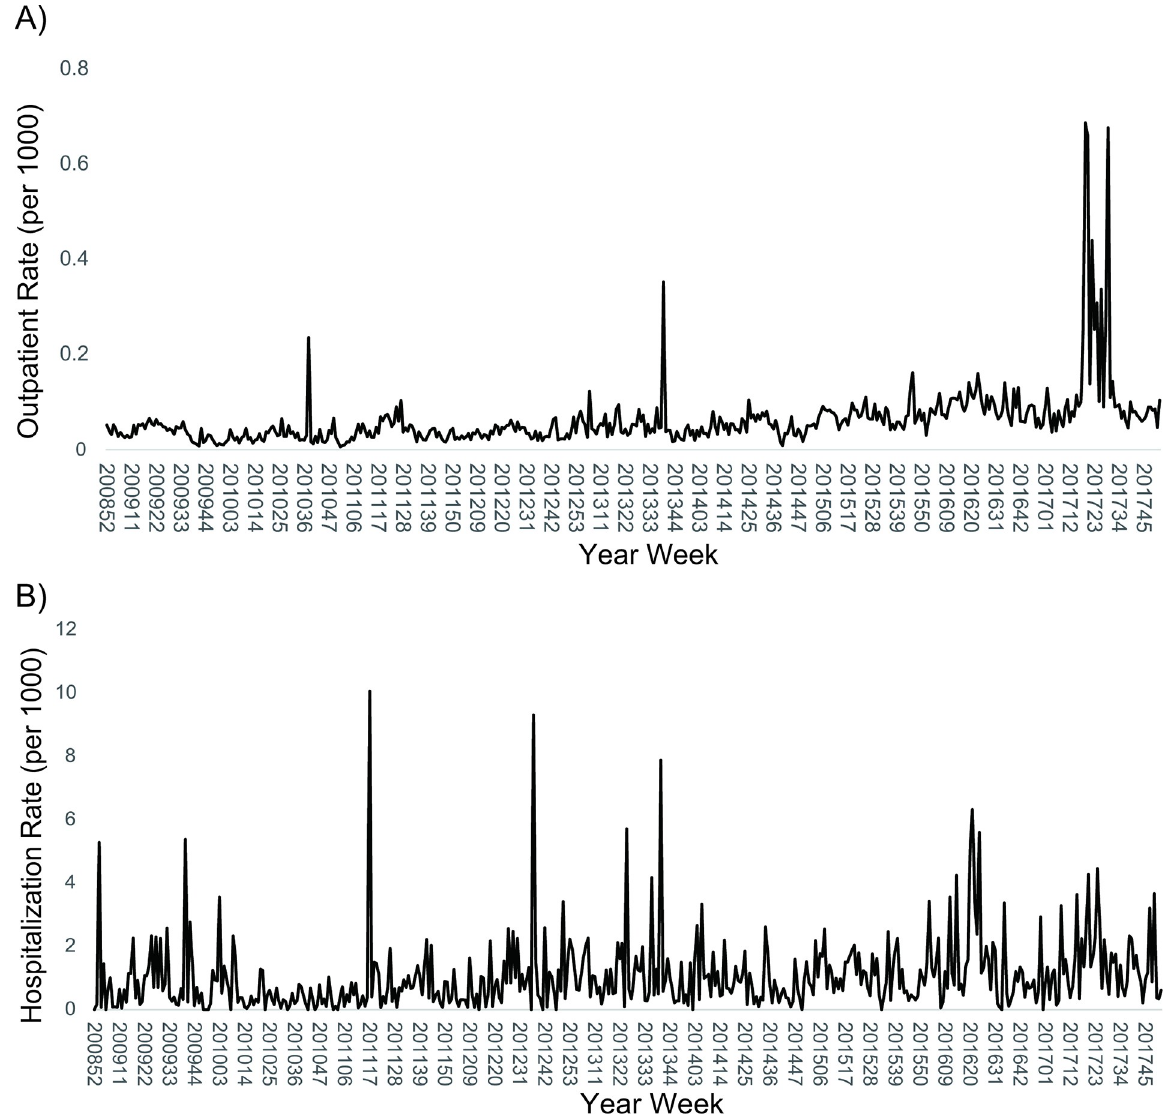
Fig 1. Temporal trend of scarlet fever, 2009 to 2017. (A) Outpatient visit rate. (B) Hospitalization